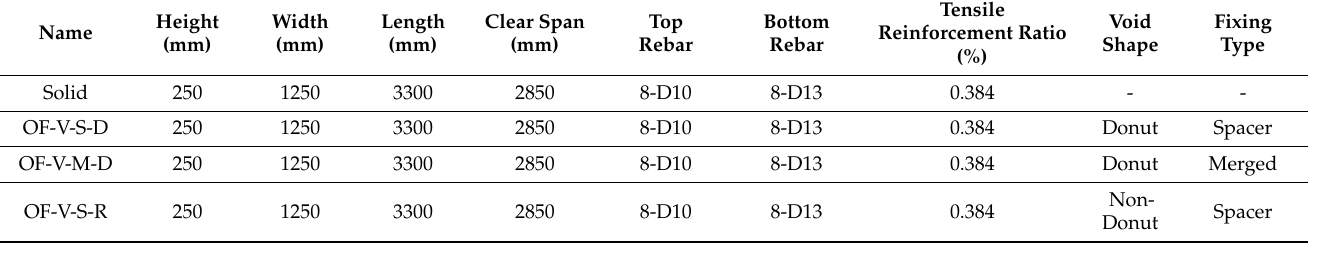
Table 5. Details of the specimens.